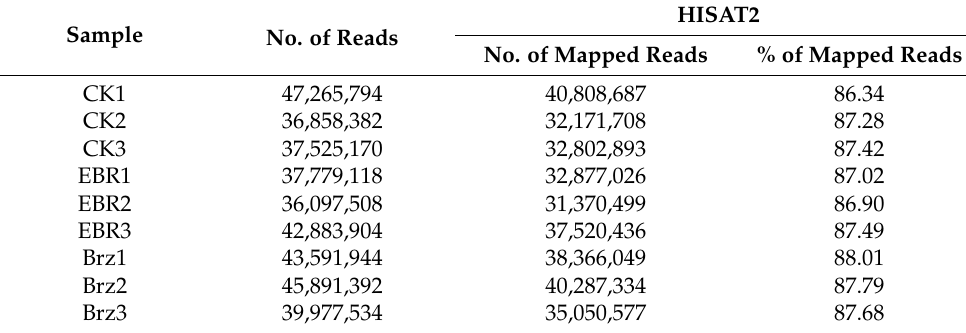
Table 1. Mapped sequence reads from RNA-seq analysis.